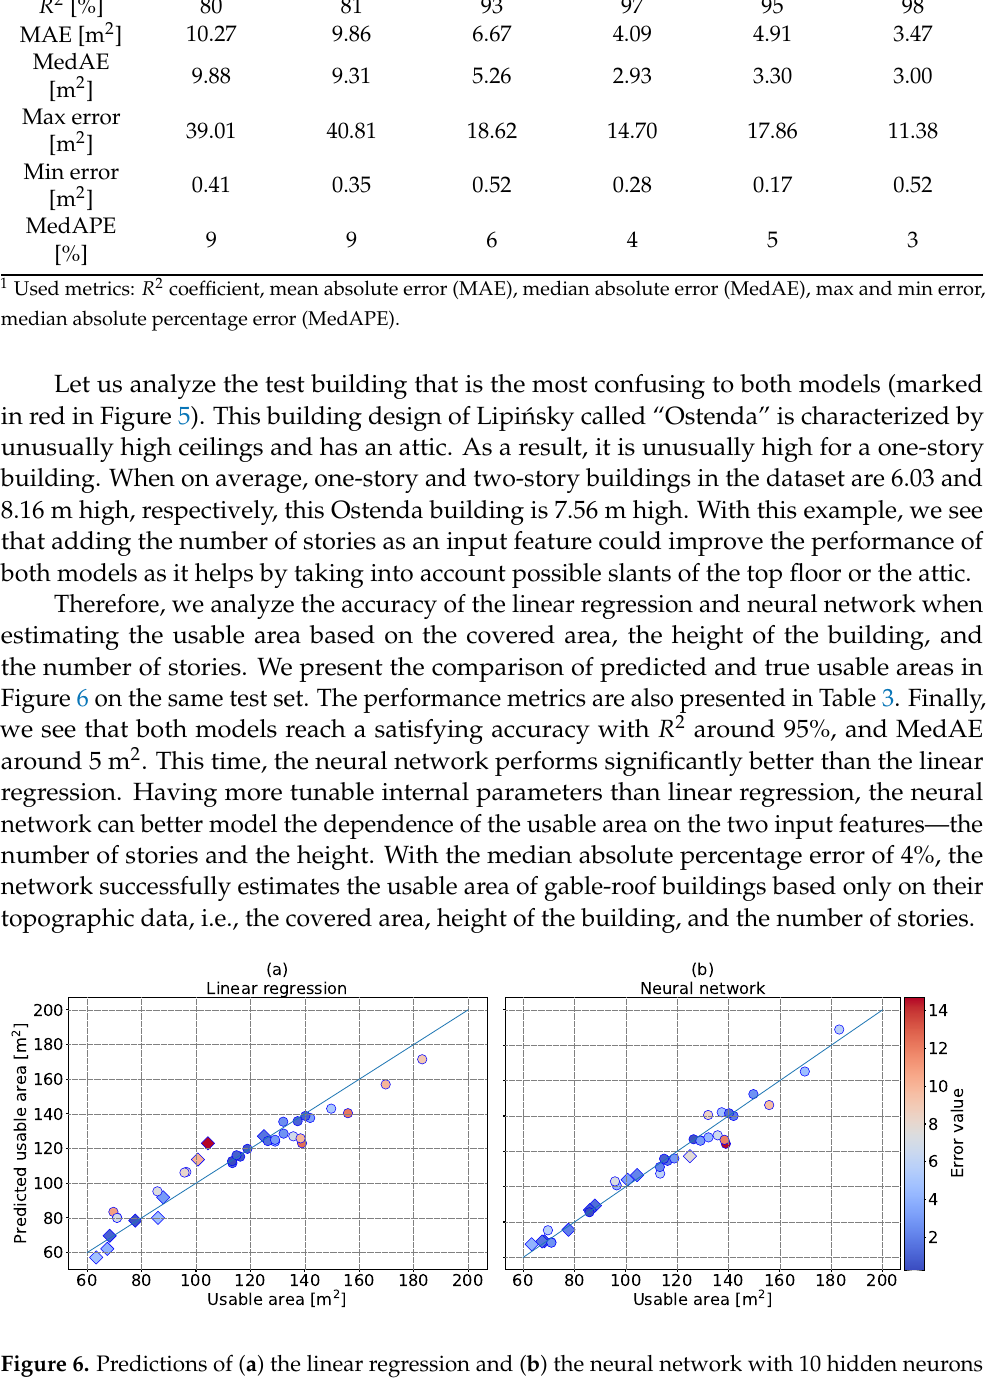
Table 3. Comparison of estimation accuracy of the linear regression model and the best found neural network models for 34 buildings from architectural bureaus with different input features, as defined in Table 1.